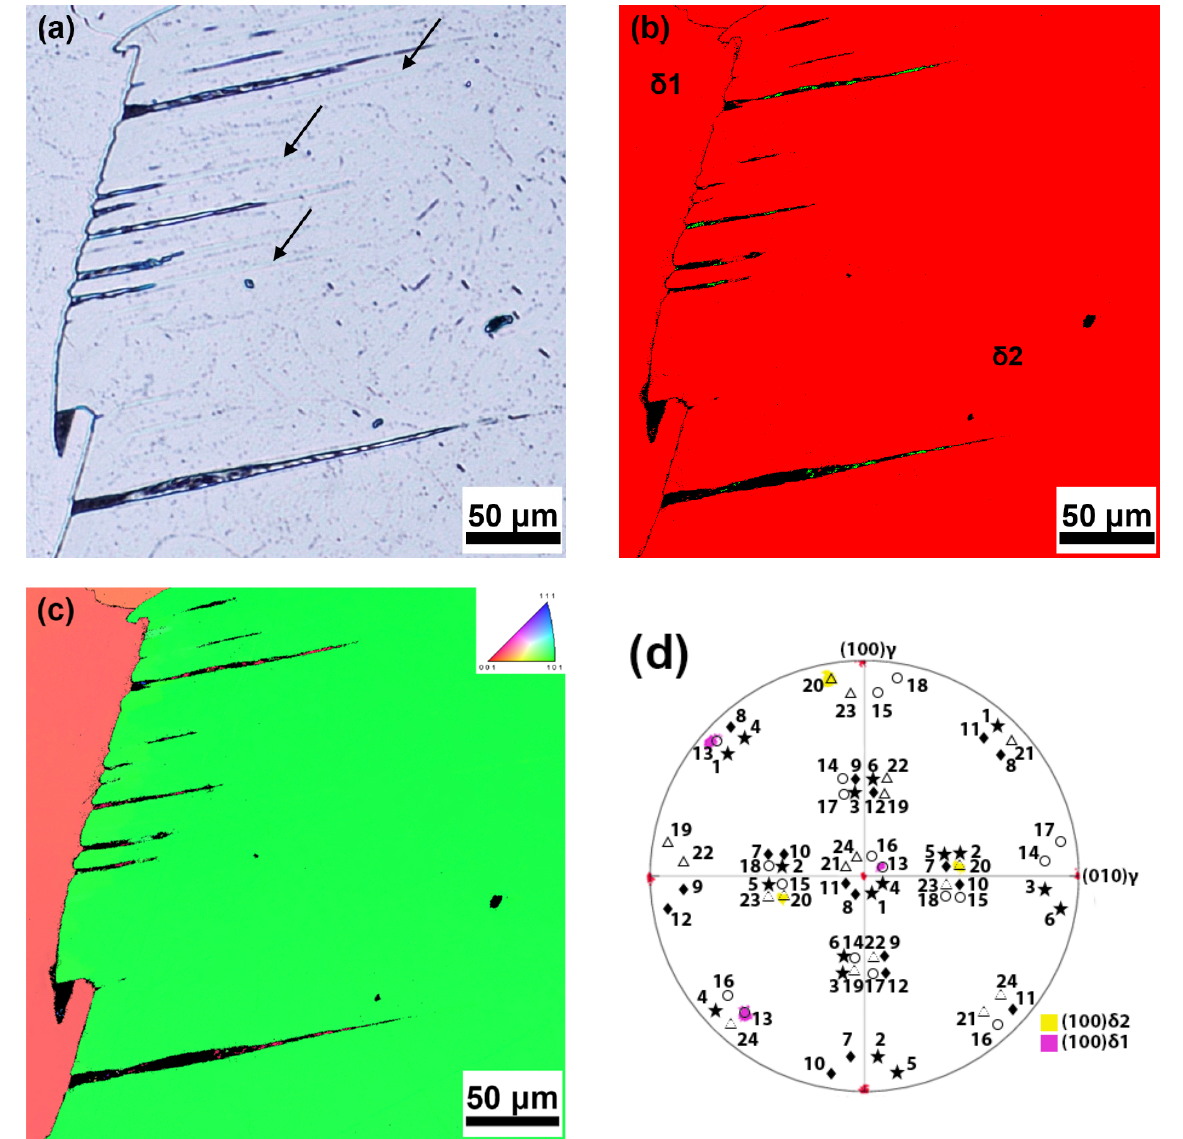
Figure 8. Decomposition of WA laths producing epitaxial ferrite, pearlite, and plate martensite + re- tained austenite; ( a ) the arrows show parts of the original WA laths, which underwent decomposition to epitaxial ferrite; ( b ) phase map, red = ferrite, green = austenite; ( c ) IPF orientation map for ND, showing that the epitaxial ferrite has the same orientation as the surrounding δ -ferrite; ( d ) combined stereographic projection (001) γ + <001> δ for K-S OR variants with inserted EBSD data obtained for both δ -ferrite